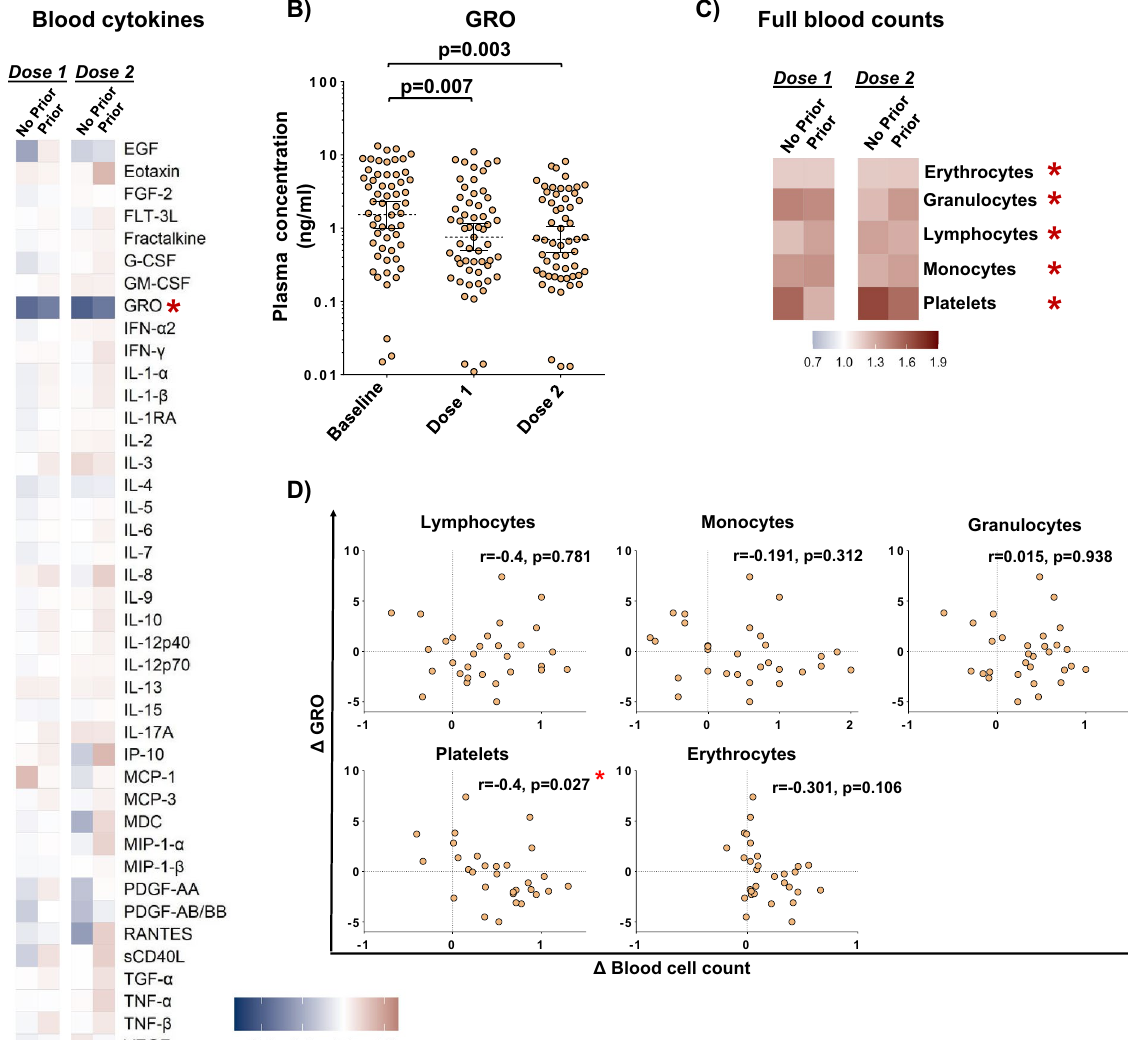
Figure 5. Systemic cytokine and cellular changes associated with Sputnik-V vaccination. ( A ) Blood cytokine changes represented as the geometric mean of fold change of each cytokine post-vaccination (after dose 1 and 2) over pre-vaccination level in the No Prior (N = 21) and Prior (N = 36) COVID-19 groups. Cytokines were plotted in alphabetical order (see the Methods and Appendix for the details). ( B ) Blood growth regulated oncogene (GRO) concentration at baseline and after Sputnik-V vaccination in the No Prior (N = 21) and Prior (N = 36) COVID-19 groups. Brackets represent geometric means and 95% confidence intervals; p values indicate the statistical significance assessed by the Mann–Whitney U test. ( C ) Changes in full blood counts (FBC) represented as the geometric mean of fold change of each cell sub-type post-vaccination (after dose 1 and 2) over pre-vaccination count in the No Prior (N = 10) and Prior (N = 25) COVID-19 groups. ( D ) Correlation plots of blood GRO (y-axis) and FBC-derived counts of major blood cell subtypes (x-axis) in all participants (n = 30). Post-dose 2/baseline ratios were log2-transformed (denoted by “ Δ ”). The Spearman coefficients (r) and their statistical significance ( p ) are shown. In panels A, C: Scale denotes fold changes, whereby 1.0 = “no change”. Stars represent statistically significant differences before and after vaccination at p <